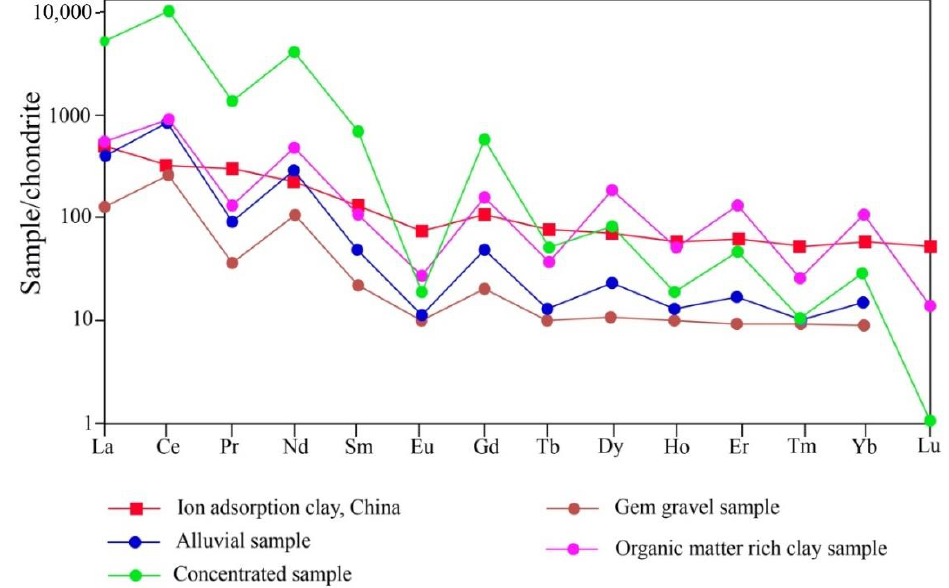
Figure 6. Chondrite-normalised REE patterns of the studied samples. Since Lu concentrations were below the detection limit, Lu values in alluvial and gem gravel samples are not plotted in this figure. Published REE values of IAC deposits in China and chondrite-normalised factors were adapted from [29] and [30], respectively.